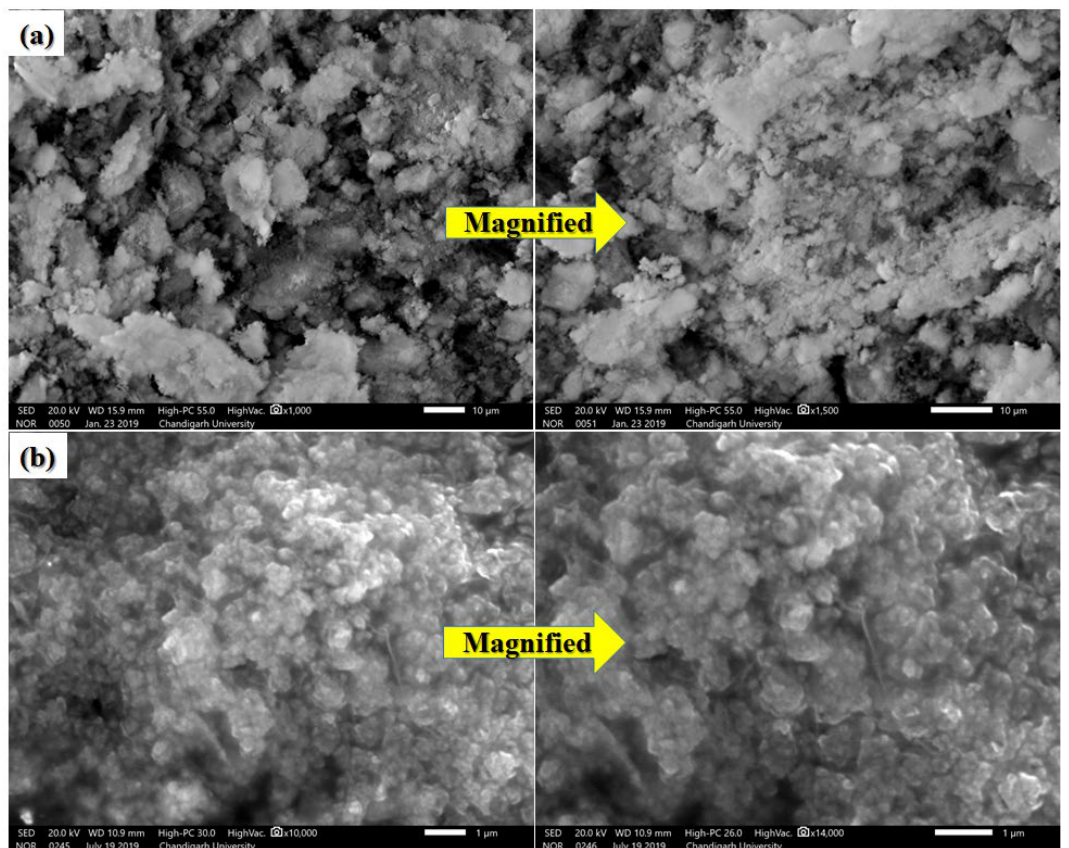
Figure 4. SEM images ( a ) HA and ( b ) HA/Au nanocomposite.